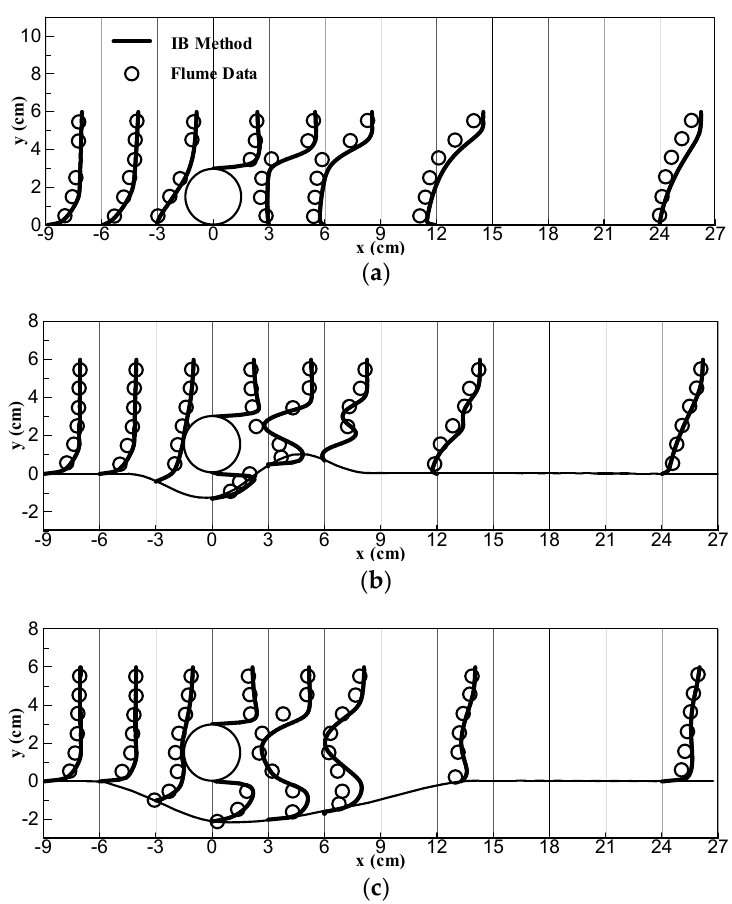
Figure 9. Comparisons of the predicted streamwise velocity ( U x ) with the measured data along eight streamwise stations. Scaling of (cid:1847) (cid:3051) is such that one unit of x is 10 cm/s. ( a ) Profile 1; ( b ) profile 2; ( c ) profile 3.